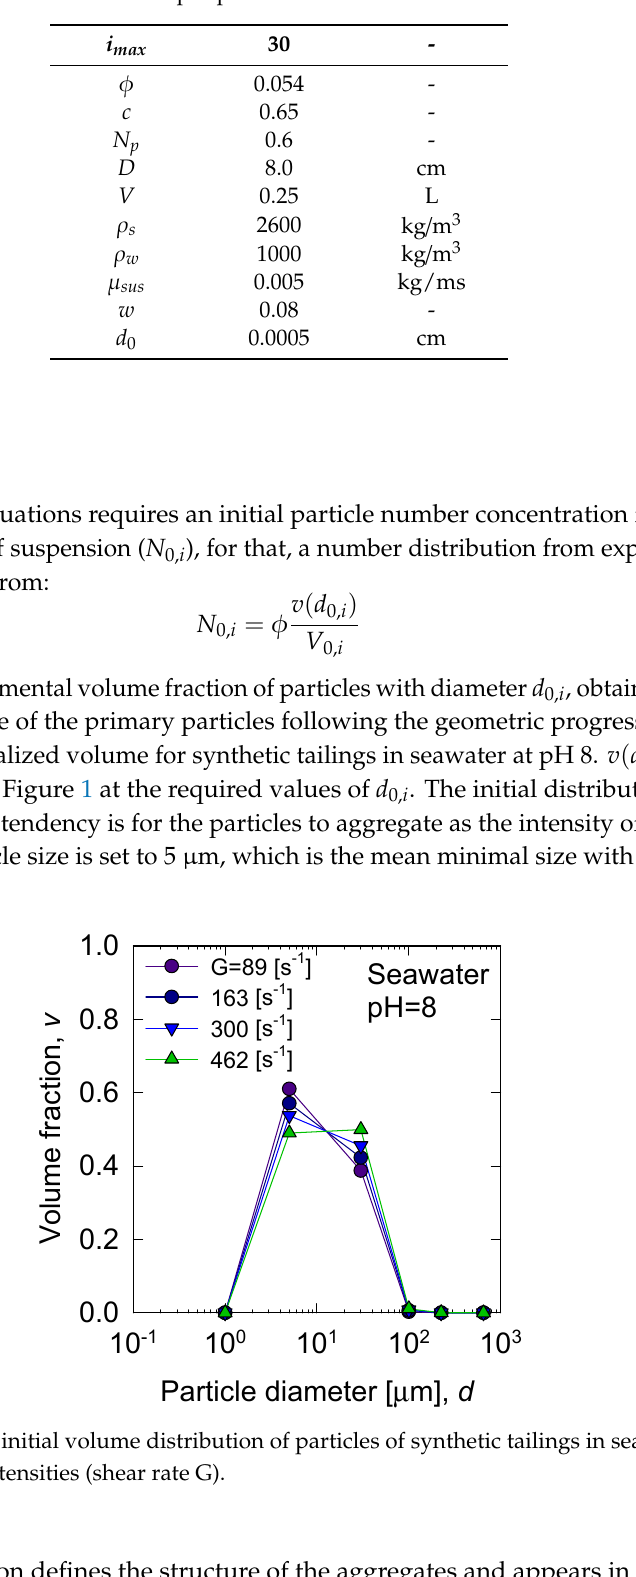
Table 1. Input parameters and conditions.